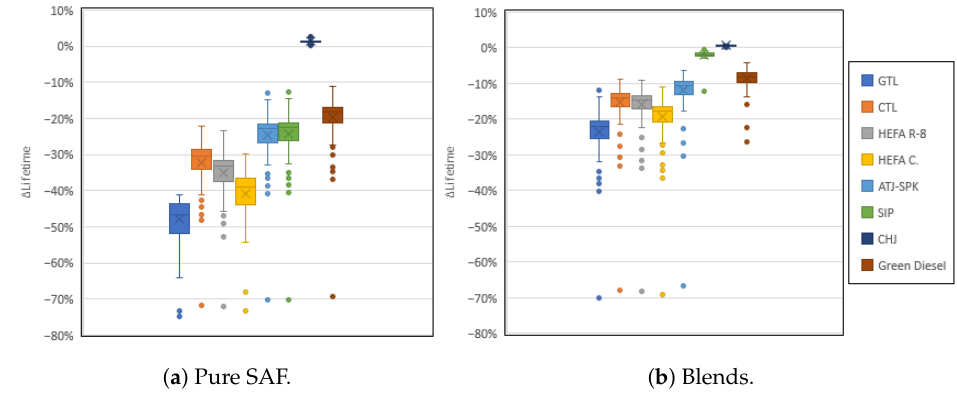
Figure 11. RDs in lifetime for reference contrails with lifetimes of over 2 h.